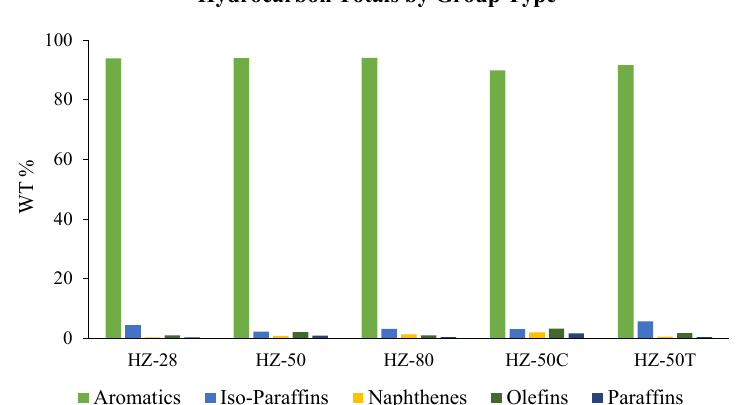
Fig. 10. Weight selectivity of hydrocarbon compounds in the liquid product of HZ-28, HZ-50, HZ-80, HZ-50C, HZ-50T catalysts in P = 1atm, T = 400 º C, WHSV = 3 h -1